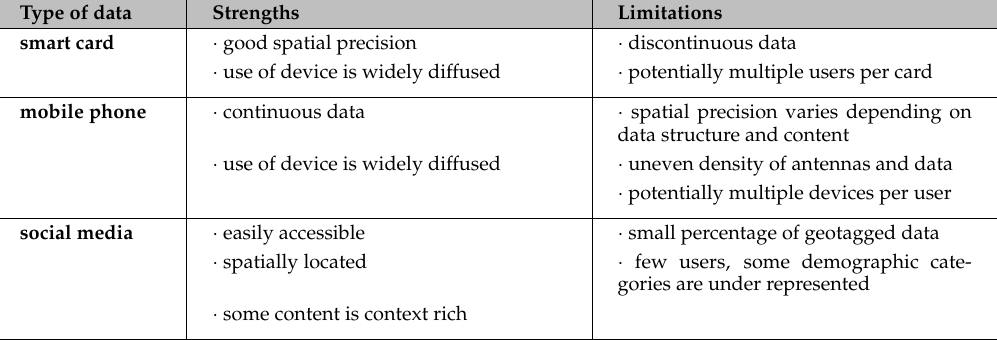
Table 1: Main types of data used in current